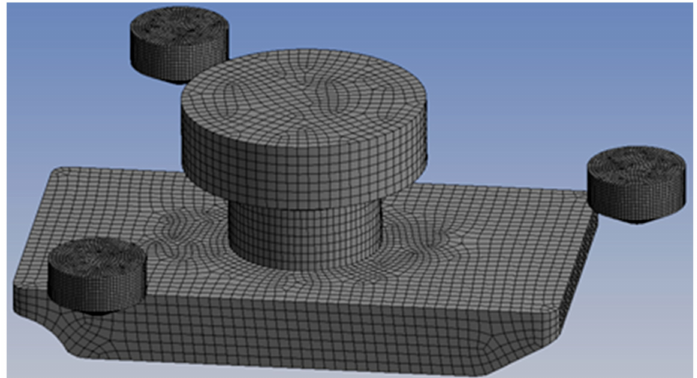
Figure 3. Grid model of semi-submerged multi-buoy WEC.